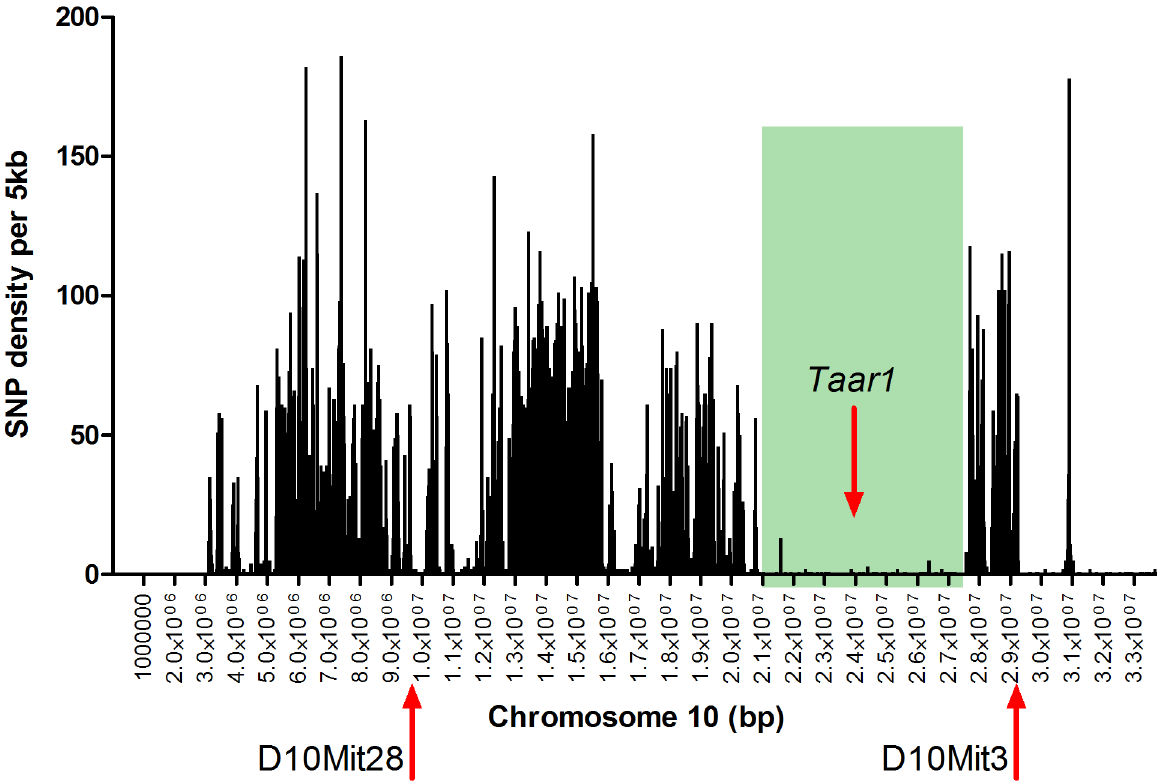
Fig 1. B6 vs D2 SNP density on proximal chromosome 10 (from 5 kb – 33.8 Mb). SNPs between B6 and D2 were counted in 5kb bins. D10Mit28 and D10Mit3 are the original PCR markers used in the BXD RI genotyping spanning the mTaar1 region [29 – 31]. The green shading indicates the 7 Mb region in which mTaar1 has the only D2 missense